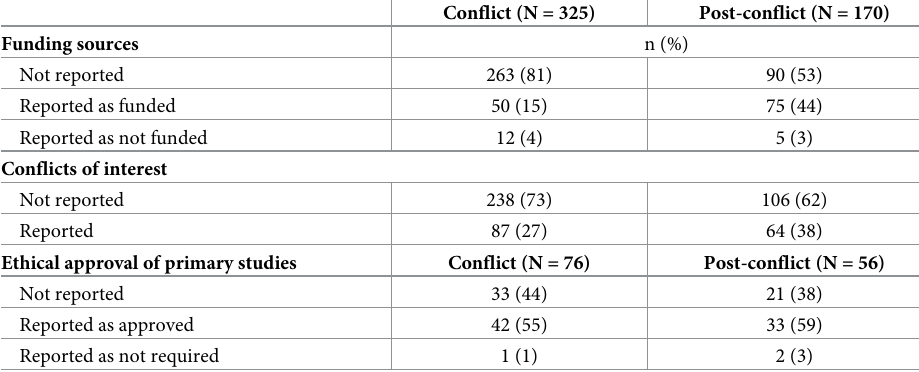
Table 3. Funding, conflicts of interest and ethics reporting characteristics of the included papers in conflict (N = 325) and post-conflict (N = 170)